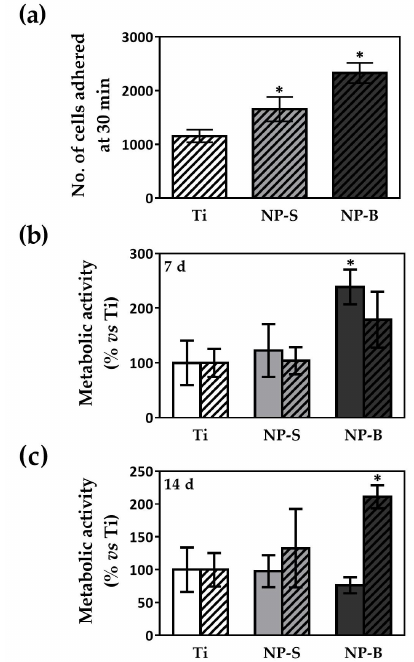
Figure 3. (a) Cell adhesion of hGF-C on the different surfaces. Number of cells adhered to the control and modified surfaces after 30 min. Data represent the mean ± SEM ( n = 6 for donor hGF-B). Differences between groups were assessed by ANOVA and post-hoc LSD test: * p < 0.05 versus Ti. ( b ) Metabolic activity of hGF-A (plain) and hGF-C (striped) at day 7 and ( c ) 14 of cell culture onto different surfaces. Data are expressed as percentage of Ti control for each day, which was set to 100%. Values represent the mean ± SEM ( n = 6). Significant differences were assessed by ANOVA and post-hoc LSD test: * p ≤ 0.05 versus Ti.